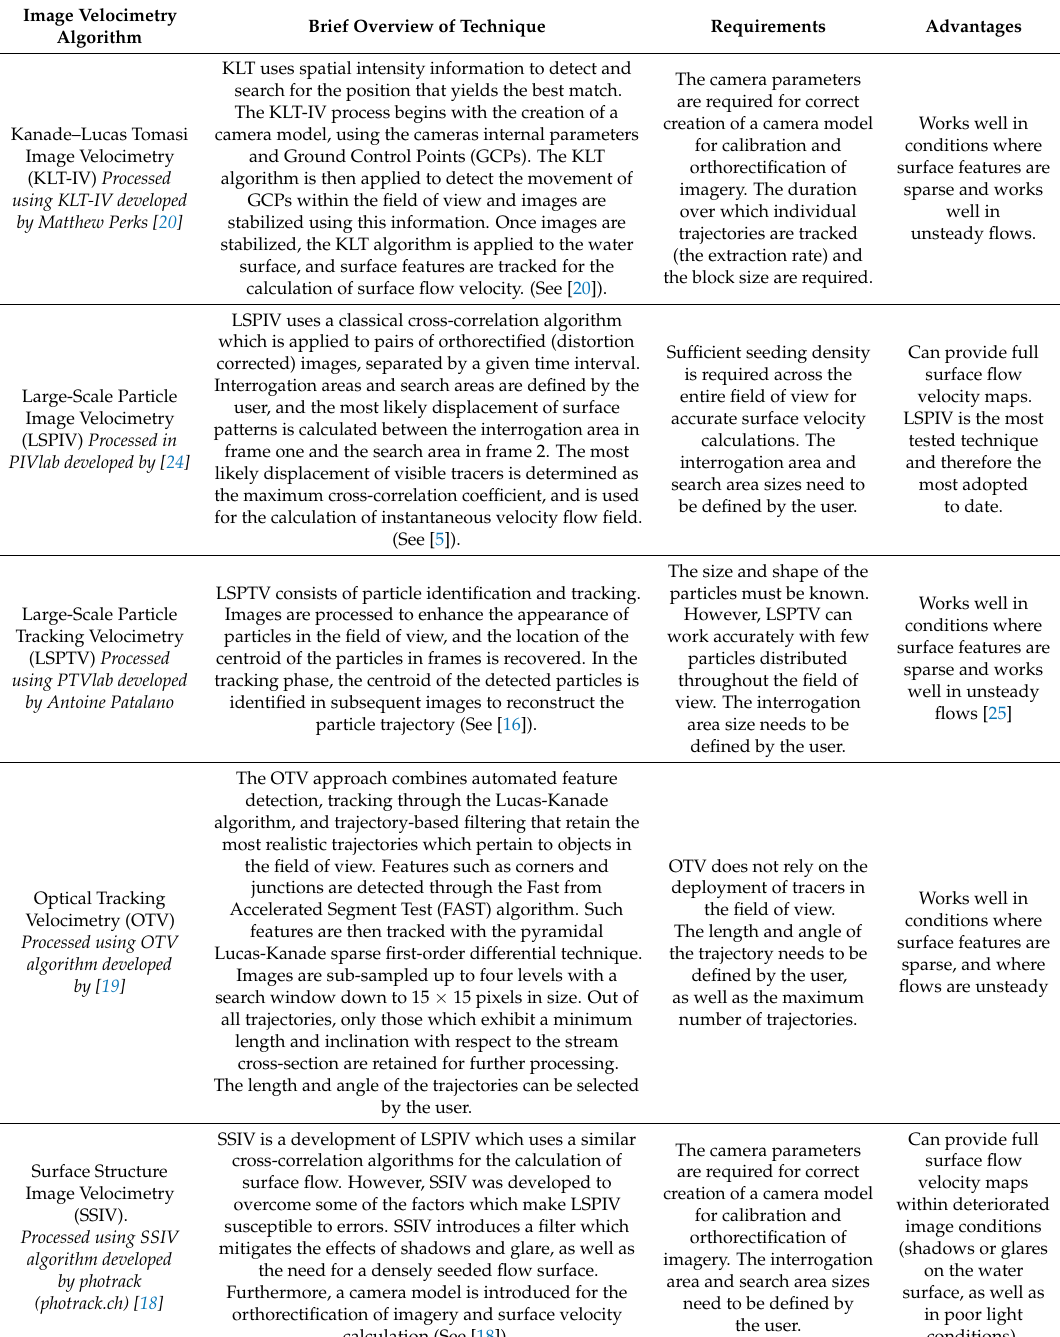
Table 1. Brief overview of the image velocimetry techniques applied throughout this